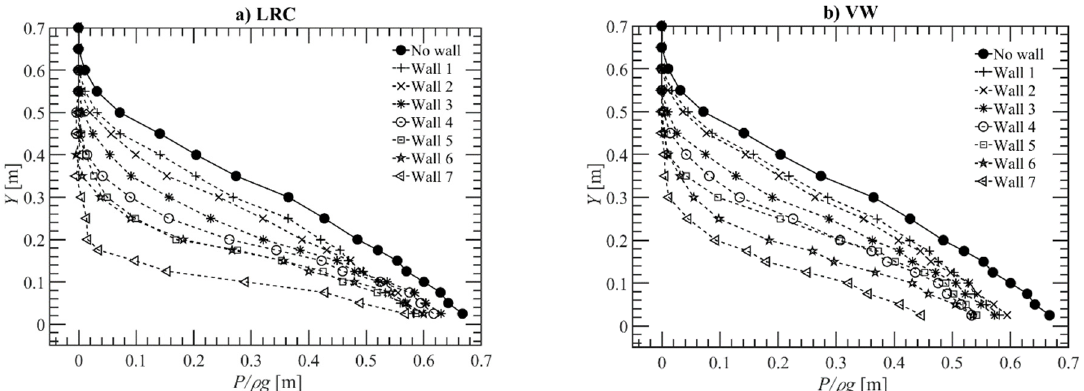
Figure 21. Pressure distribution at the structure front at the time of maximum moment for the LRC and the VW for d o = 0.9 m and L = 2